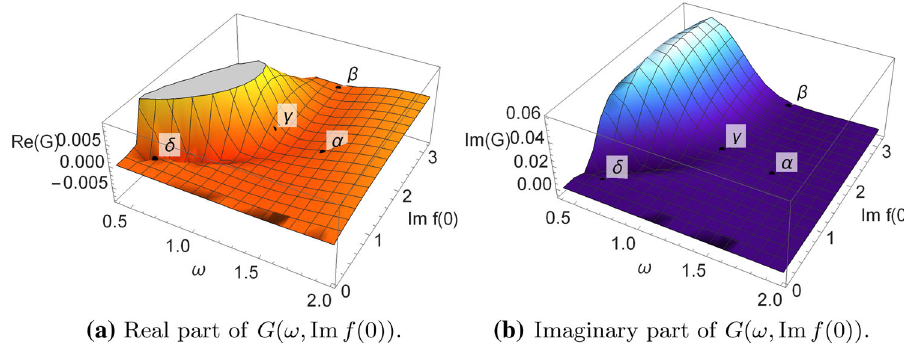
Fig. 11 Three dimensional plots of the constraint function G (ω, Im f ( 0 )) for the hyperbolic solutions in five